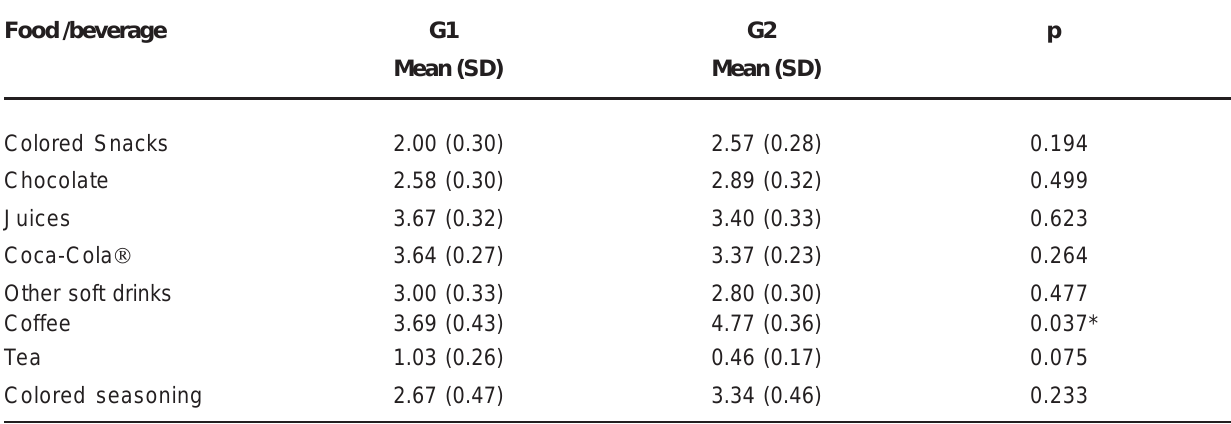
TABLE 4- Fisher’s exact test for the comparison of dentist’s and subjects’ perception of tooth staining Subjects’ perception